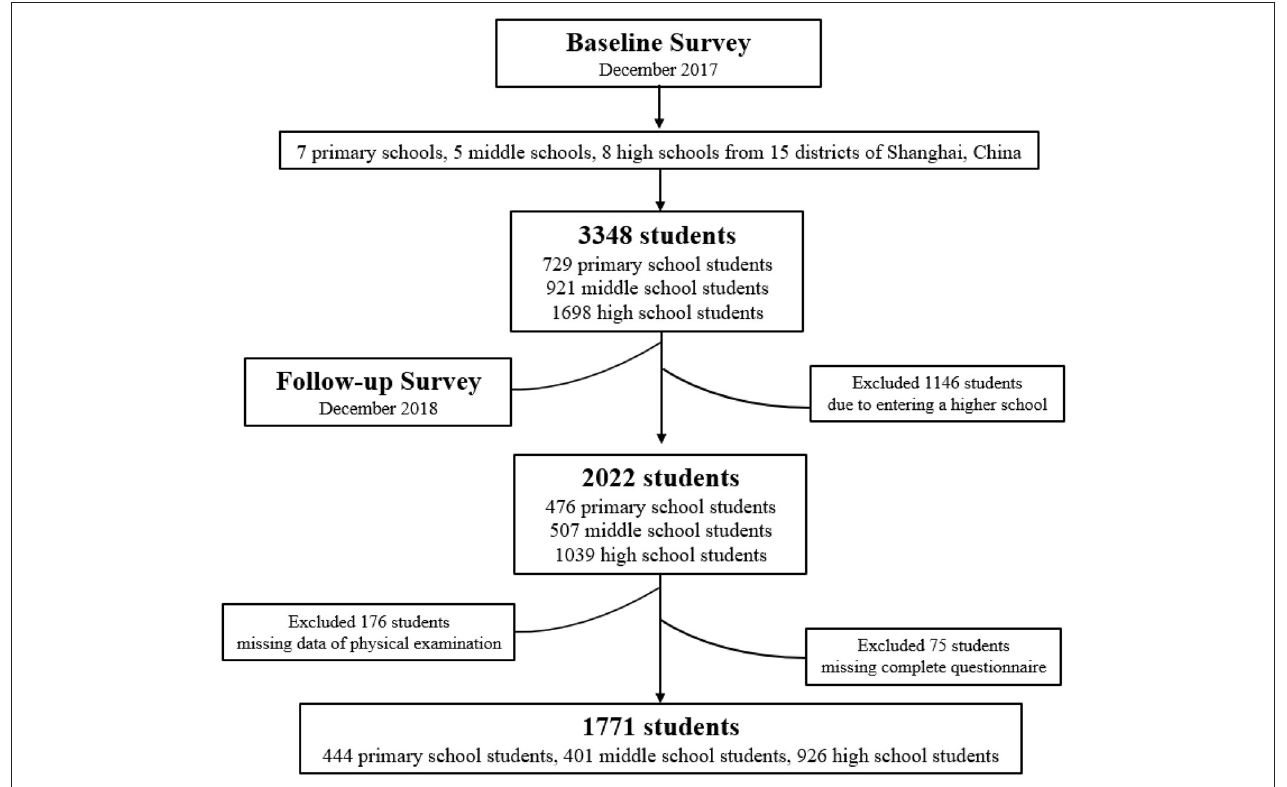
FIGURE 1 | The flowchart of this cohort study.